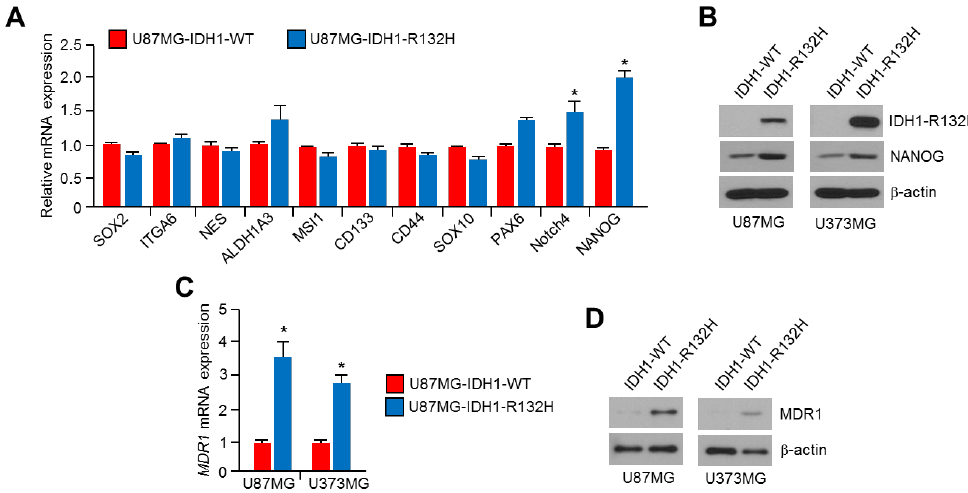
Figure 3. Overexpression of IDH1 R132H increases NANOG expression in U87MG and U373MG glioblastoma cells. ( A ) IDH1-WT or IDH1 R132H overexpressing U87MG cells were incubated for 24 h. Gene expression levels were measured by using qRT-PCR. The values represent the mean ± SD of three independent experiments performed in duplicate; * p < 0.05. ( B ) IDH1 R132H and NANOG protein levels in IDH1-WT or IDH1 R132H expressing U87MG and U373MG cells were measured by using Western blotting. ( C ) IDH1-WT or IDH1 R132H overexpressing U87MG cells were incubated for 24 h. Gene expression levels were measured by using qRT-PCR. The values represent the mean ± SD of three independent experiments performed in duplicate; * p < 0.05. ( D ) MDR1 protein levels in IDH1-WT or IDH1 R132H expressing U87MG and U373MG cells were measured by using Western blotting.